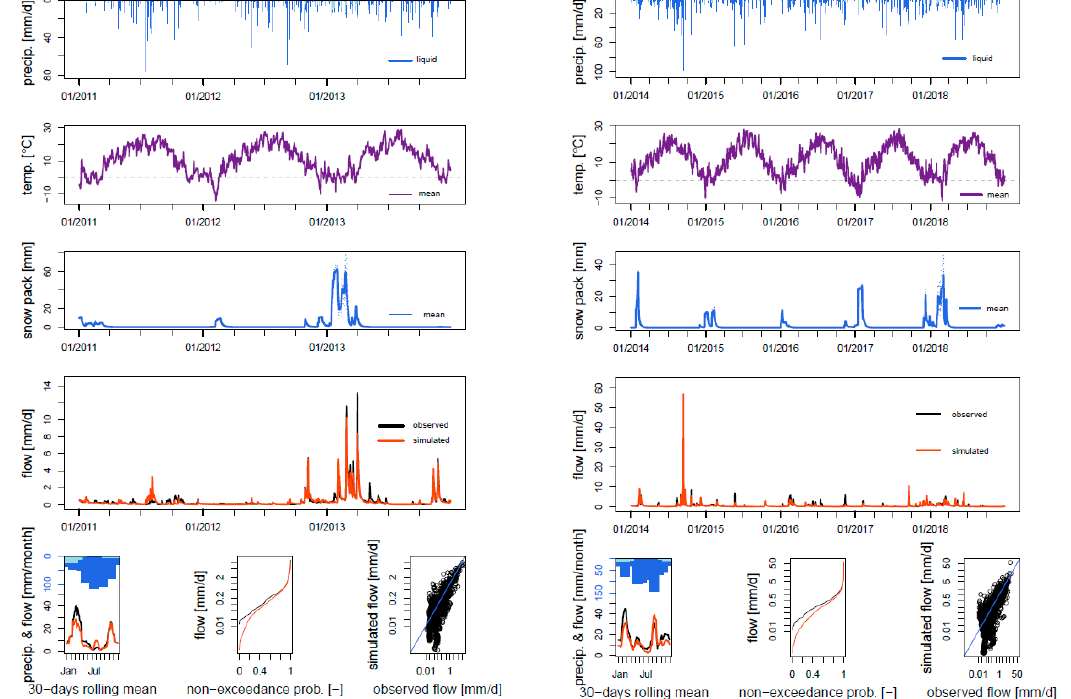
Figure 3. Evaluation of the CemaNeige GR6J model for the calibration ( left ) and validation ( right ) period. Top two panels show input precipitation and air temperature data. Middle panel shows modelled snow pack values. Lower two panels show a comparison between simulated and observed discharge data using daily discharge values, 30-days rolling mean, flow duration curve, and scatter plot.